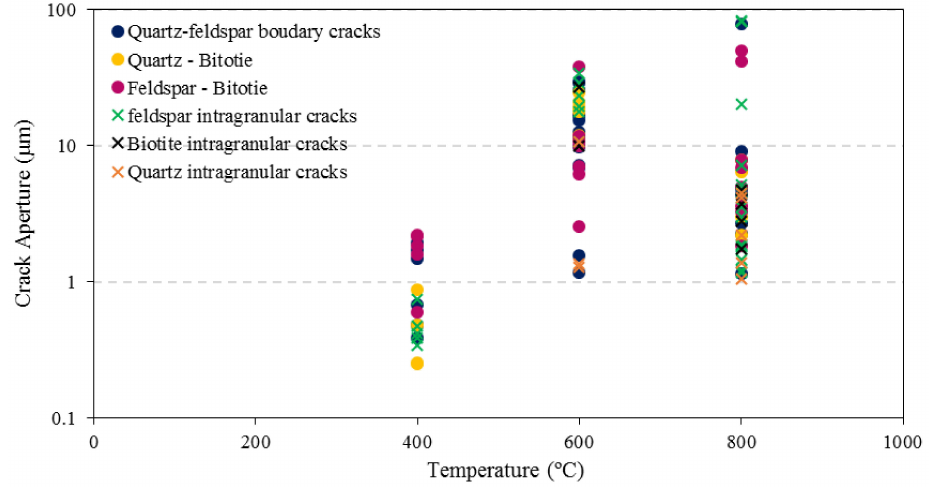
Figure 6. Distribution of inter-granular and intra-granular crack apertures over pre-heating temperature or specimens subjected to rapid cooling